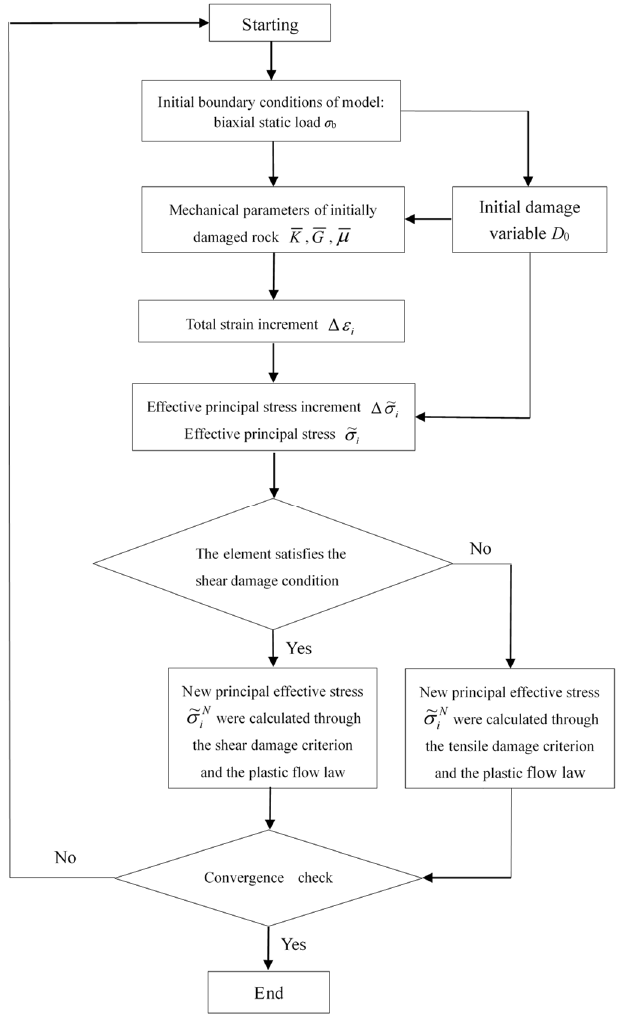
Figure 6. Calculation flow of the Mohr-Coulomb elasto-plastic constitutive model of the rock considering the initial damage.